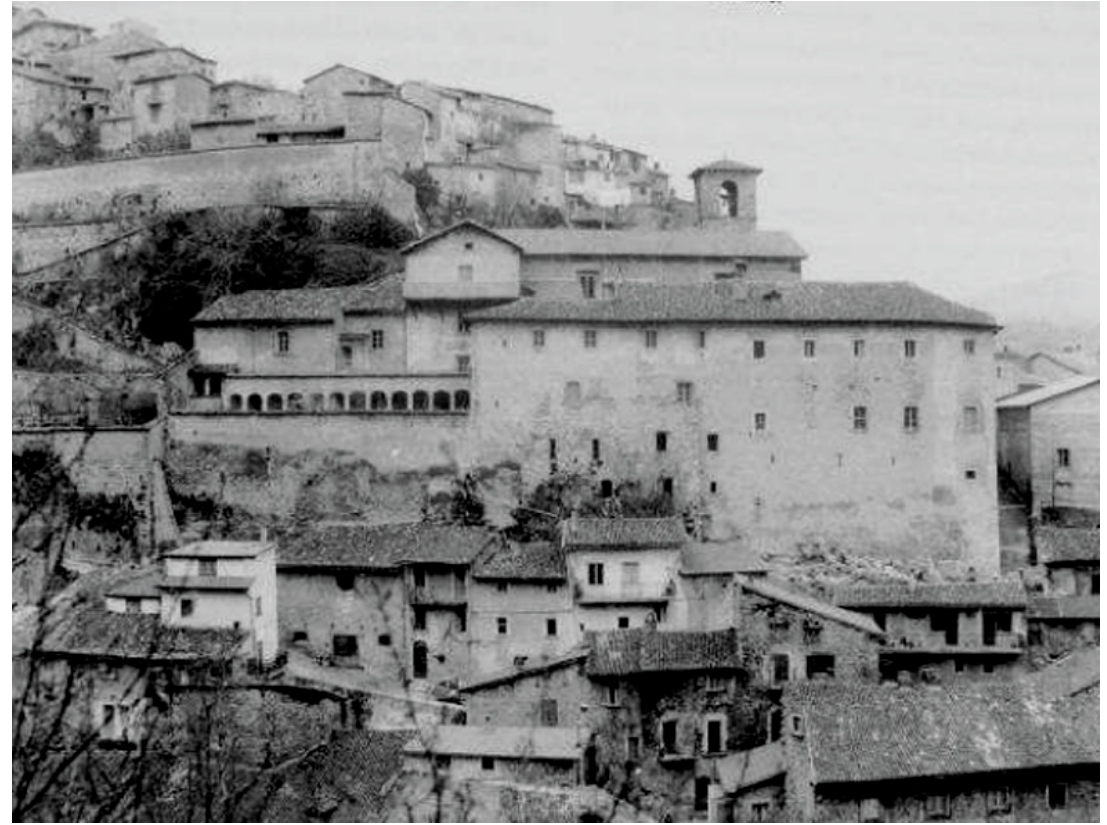
Figure 2. Southern side of the Monastery of Saints Cosma and Damiano [39,43] in a photo dating back to the 1940s.